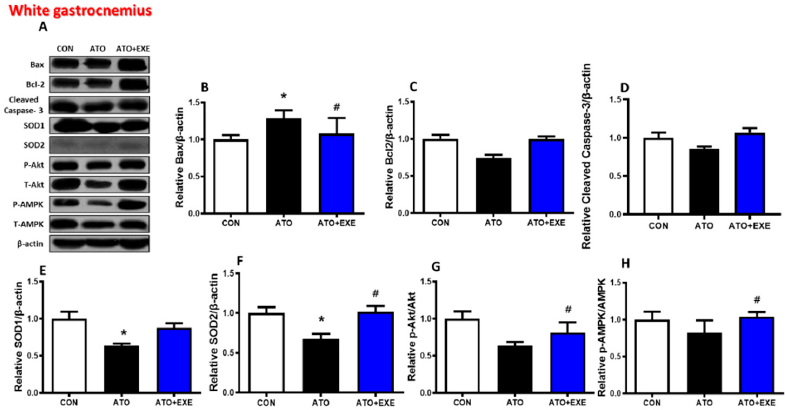
Figure 4. Effects of exercise training on mitochondria-mediated apoptotic signaling in the skeletal muscles of rats treated with atorvastatin. Quantification of Western blots normalized to β -actin. ( A ) bands; ( B ) Bax; ( C ) Bcl-2; ( D ) cleaved caspase-3; ( E ) SOD1; ( F ) SOD2; ( G ) p -Akt/t-Akt; ( H ) p -AMPK/t- AMPK. Data are presented as means ± SEM. * p < 0.05 vs. CON; # p < 0.05 ATO.